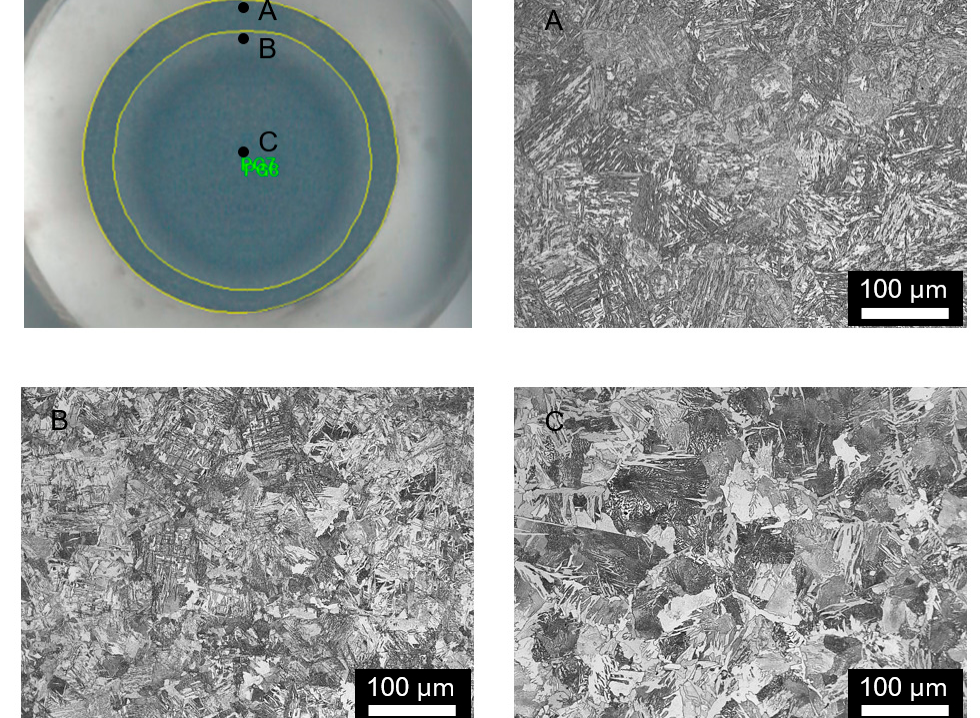
Figure 11. Microstructures obtained from TPS after cooling time of 2.0 s. (A: surface layer; B: transition layer; C: center core.).